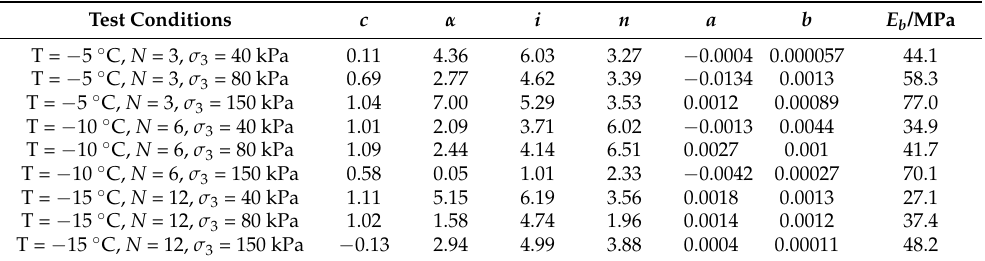
Table 4. The parameters of the model.